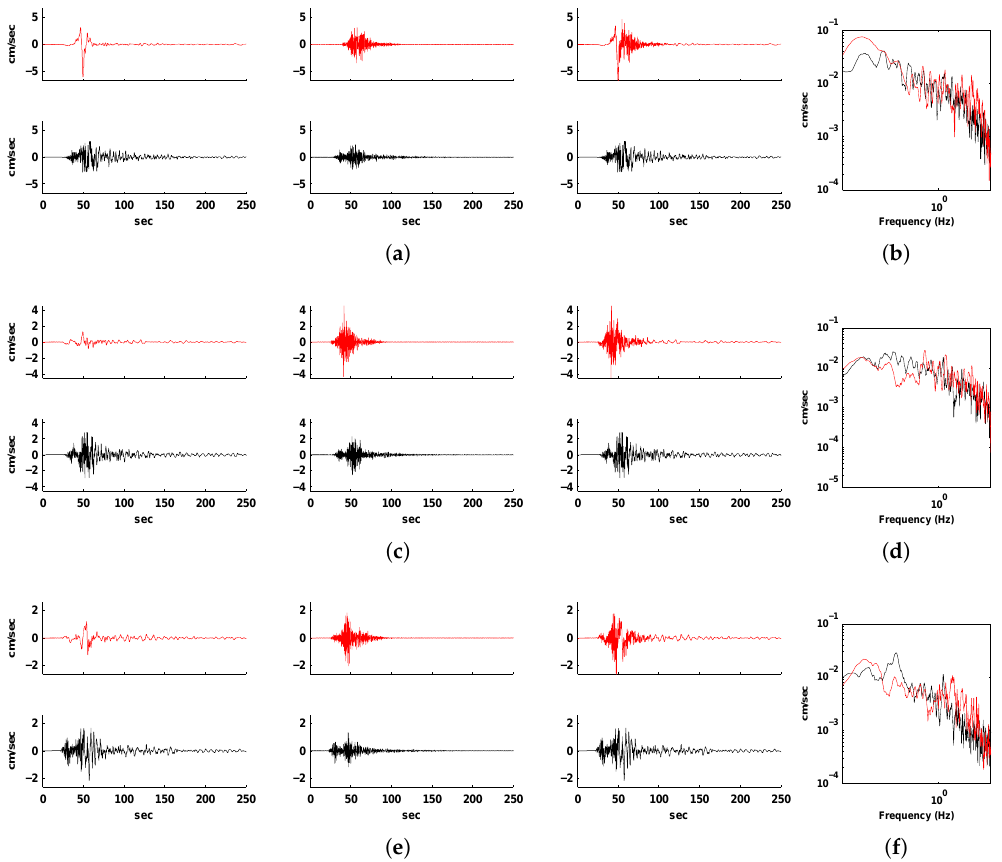
Figure 8. ( a ) North-south component, ( c ) east-west component, and ( e ) vertical component of ground velocity histories at Station 30. Shown in red are the long-period spectral-element-simulated (column 1), high-frequency EGF-synthesized (column 2), and combined broadband histories (column 3) for the 1999 Hector Mine earthquake. Shown in black are the corresponding filtered observed ground velocity records for comparison. ( b , d , f ) show the comparison of the corresponding spectra of the broadband velocity histories (red: synthesized, black: